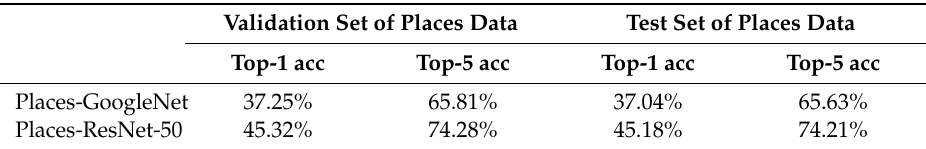
Table 7. The classification accuracy on our validation and test datasets of pre-trained PlaceNet.